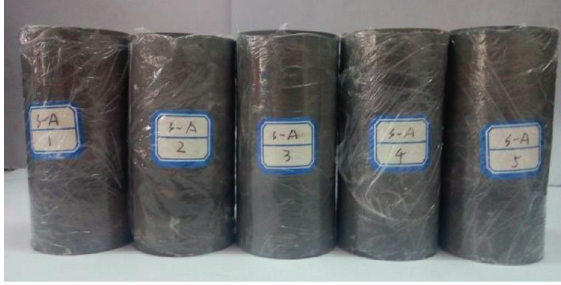
Figure 2: Limestone specimens.